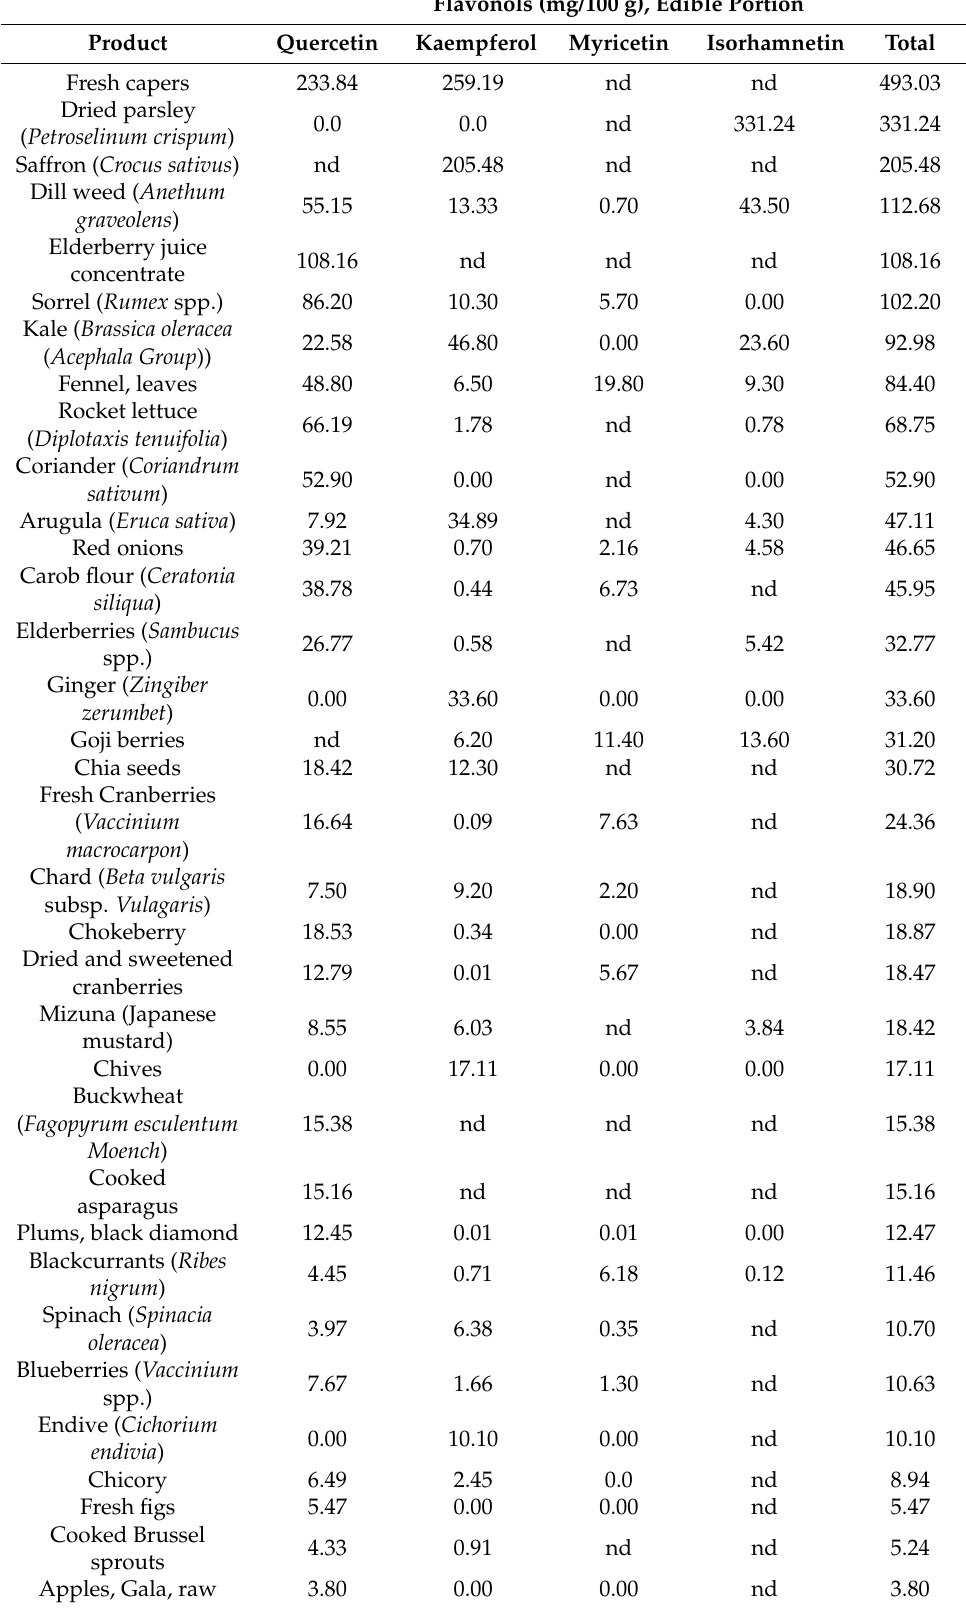
Table 1. Content of flavonols in selected foodstuffs (mg per 100 g of foodstuff), based on